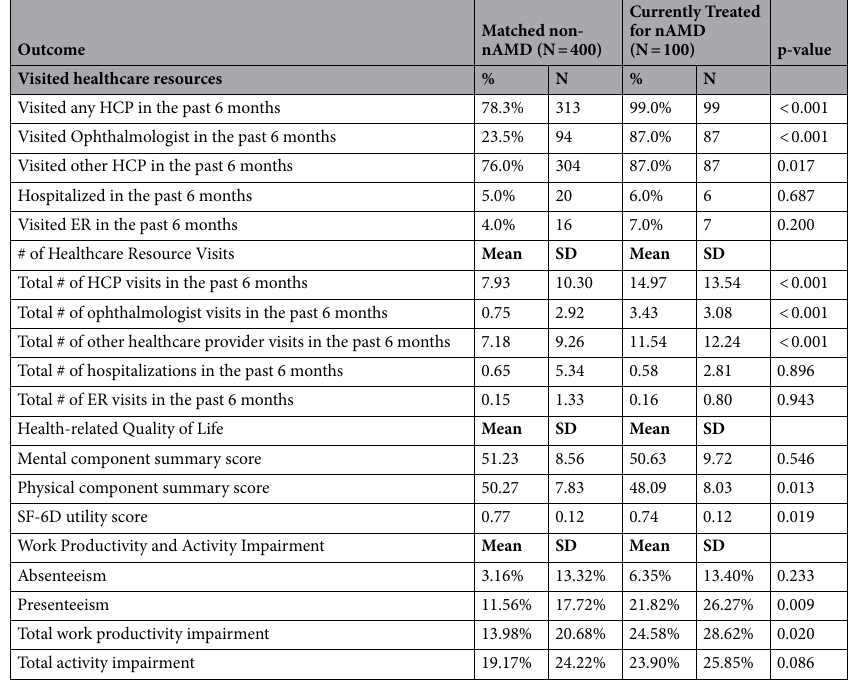
Table 2. Unadjusted means and standard deviations or count and percentages of health outcomes among currently-treated nAMD patients and matched non-nAMD respondents. nAMD neovascular age-related macular degeneration, HCP healthcare provider, ER emergency room, SD standard deviation.